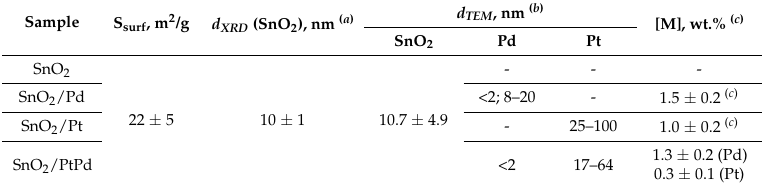
Table 1. Microstructure characteristics and composition of investigated